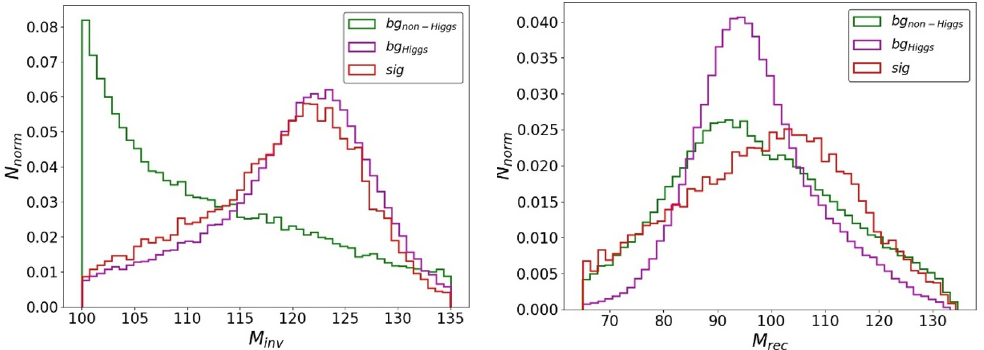
Figure 18 . Event distributions of M inv (left) and M rec (right), de(cid:12)ned in eq. (4.10), for the (cid:23)(cid:23)h h and its background samples after